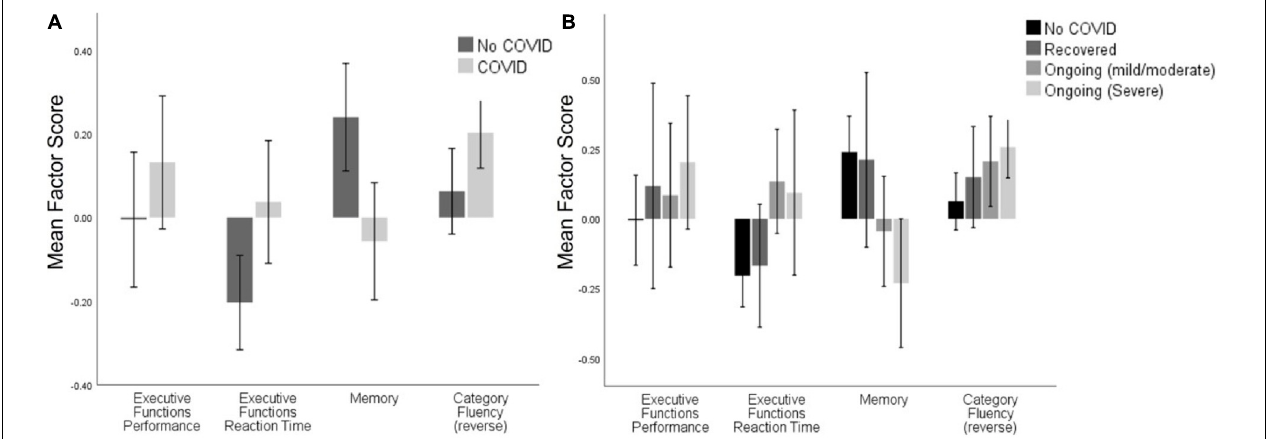
FIGURE 2 | Cognitive task factor scores across (A) the No COVID group and the COVID group, and (B) the No COVID group and the three ongoing severity groups. Significant differences were seen between the No COVID group and Ongoing (Mild/Moderate) on Memory [ t (87.6) = 2.4, p = 0.018], and between No COVID and Ongoing (Severe) on Memory [ t (99.8) = 3.9, p < 0.001] and Category Fluency [ t (152) = 3.05, p < 0.003]. After controlling for demographic variables, only the differences in Memory maintained significance (see Supplementary Table 2 ). Error bars: ± 2